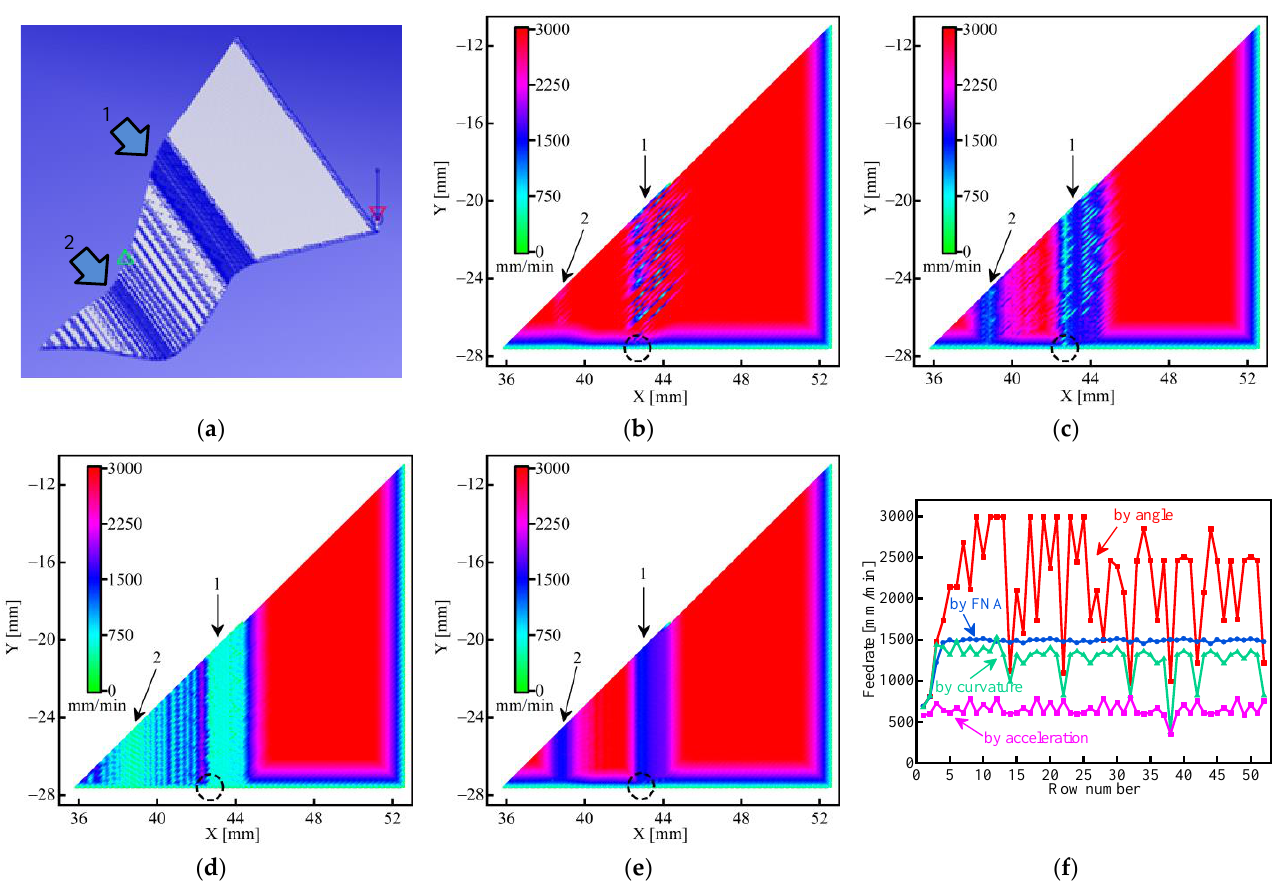
Figure 9. The feedrate results of the 3D machining path: ( a ) the line segments of the free-form surface; the feedrate results of the ( b ) angle-constraint, ( c ) curvature-constraint, ( d ) acceleration-constraint and ( e ) FNA method; ( f ) the feedrate of each row when X = 43 mm.